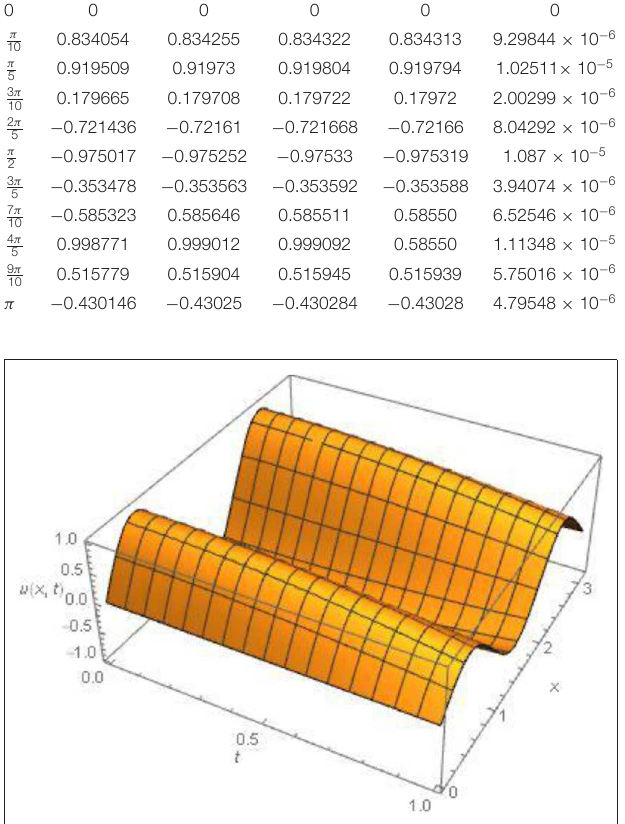
FIGURE 3 | Approximate solutions for TFPPDE (20) for distinct values of α 2. = 1.5, 1.75, 2.